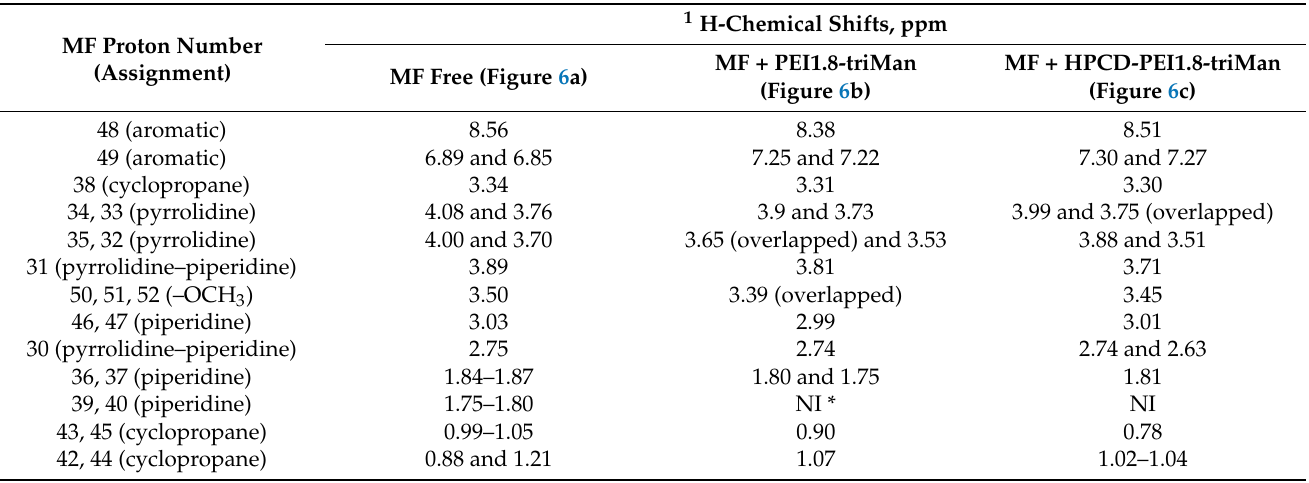
Table 4. 1 H-chemical shifts corresponding to MF in free form and in the form of non-covalent complexes with ligands 2a and 2b (PEI1.8-triMan and HPCD-PEI1.8-triMan). D 2 O, 400